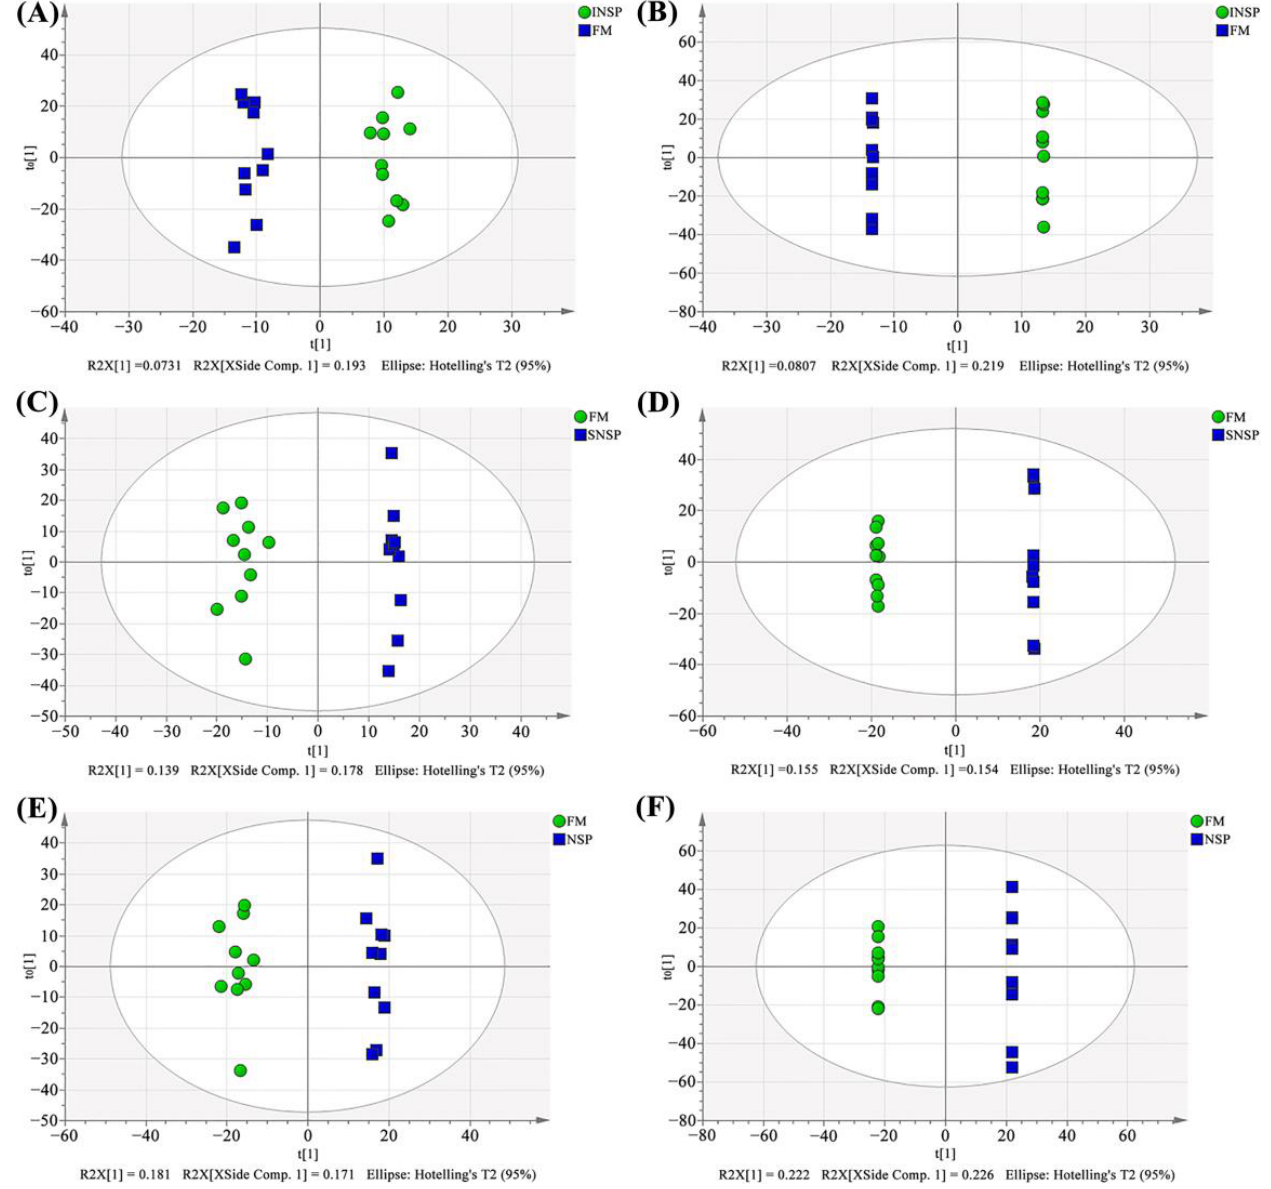
Figure 5. Serum metabolite profiles OPLS-DA analysis results. ( A , B ) plots of OPLS-DA scores in positive and negative ion mode between FM and INSP groups, respectively; ( C , D ) plots of OPLS-DA scores in positive and negative ion mode between FM and SNSP groups, respectively; ( E , F ) plots of OPLS-DA scores in positive and negative ion mode between FM and NSP groups, respectively.